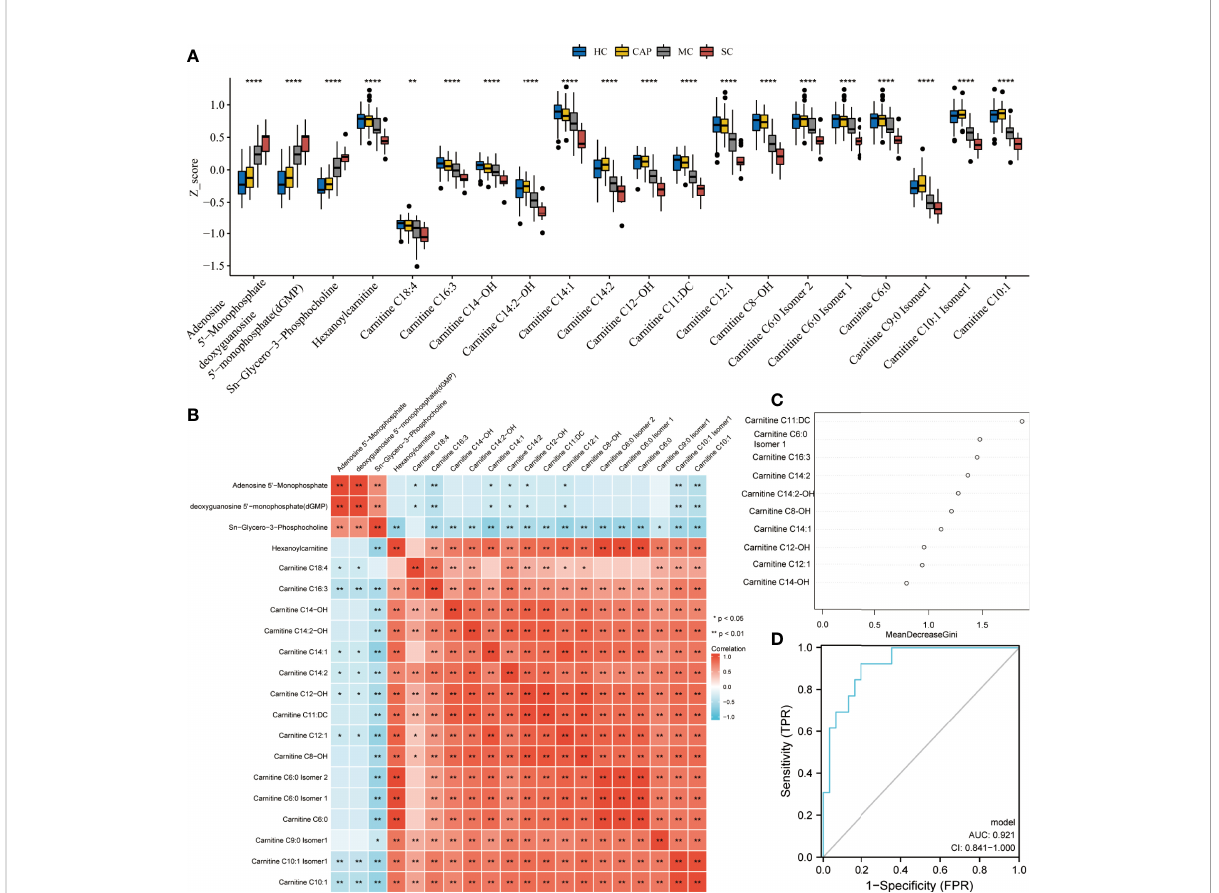
FIGURE 8 Metabolite performance in predicting severe COVID-19. (A) Kruskal test revealing signi fi cant differences between all tested groups: healthy controls (HC), community-acquired pneumonia (CAP), mild COVID-19 (MC), and severe COVID-19 (SC) patients. All metabolite pro fi les were fi rst log2 transformed and then normalized using Z-score standardization. (B) Pearson correlation analysis of differential metabolites. (C) The top ten ranking metabolites are indicated by random forest. (D) Predictive performance of biomarker metabolites evaluated by ROC analysis. * P < 0.05, ** P < 0.01, *** P < 0.001, **** P <